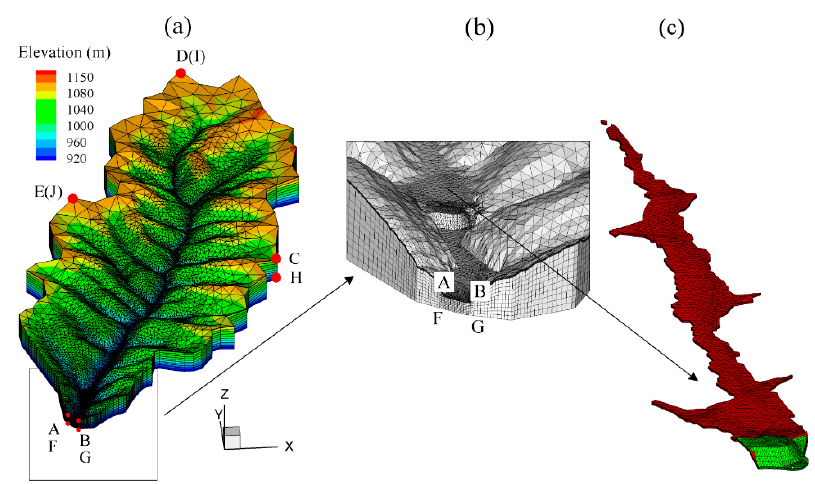
Figure 3. 3D mesh used in scenario-1: ( a ) the whole catchment and boundary conditions; ( b ) the outlet area and the outflow boundary; ( c ) the surface mesh representing the filled check dam (S1-1) and its sedimentary land. Note that the elevation of sedimentary land was the same as that of the spillway on the right side of the check dam, indicating the check dam was